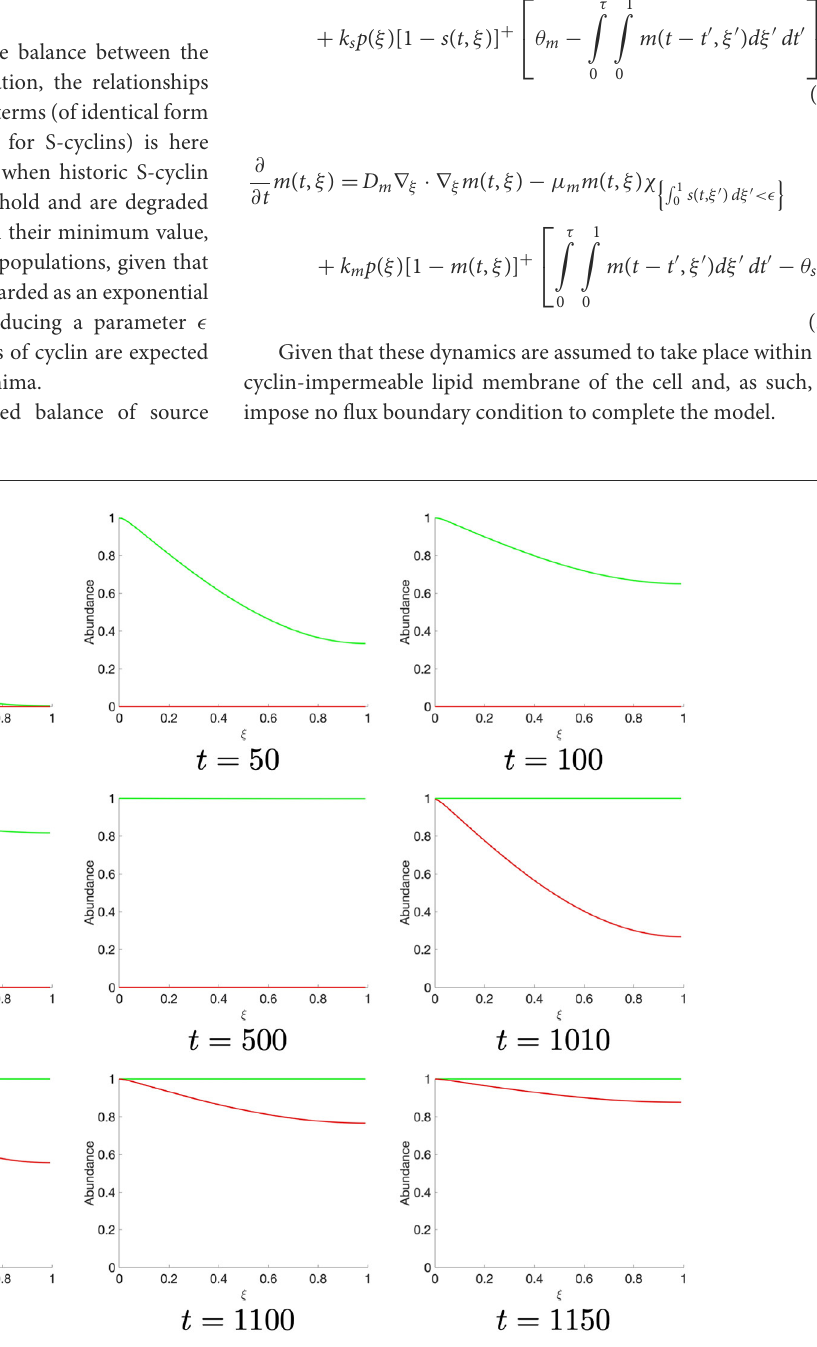
FIGURE2 Spatial S- (red) and M- (green) cyclin state estimated for t